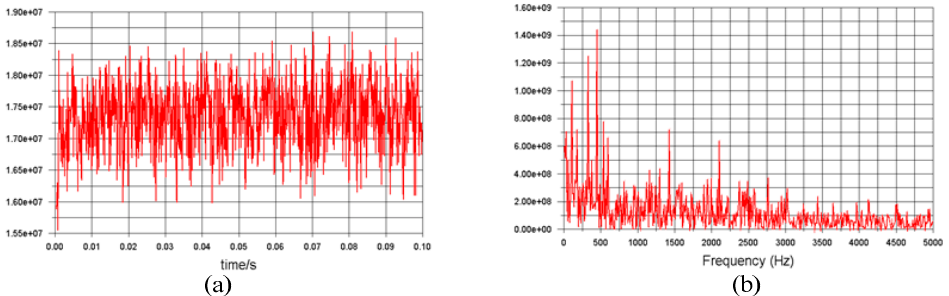
Figure 22. Pressure oscillation curve of the flapper considering the impression of the main valve and velocity of 50 m / s. ( a ) Time domain. ( b ) Frequency domain.